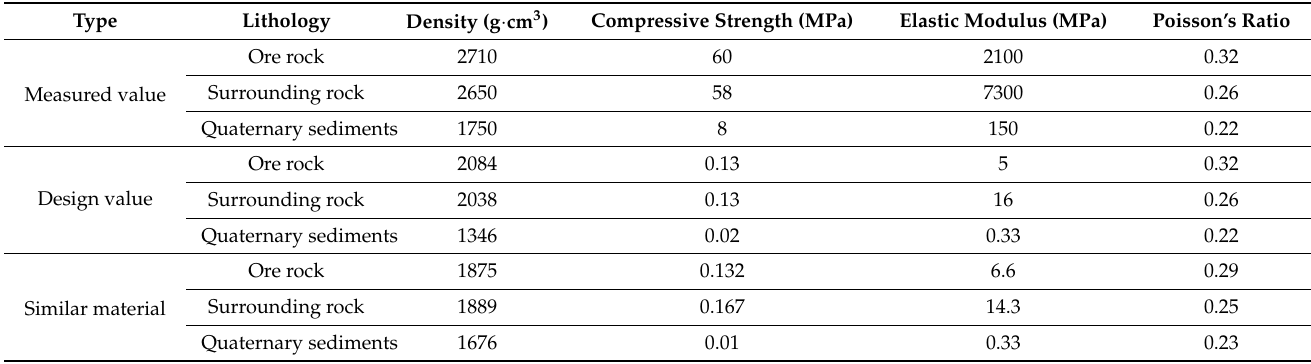
Table 3. Physical and mechanical parameters of the rock mass and similar